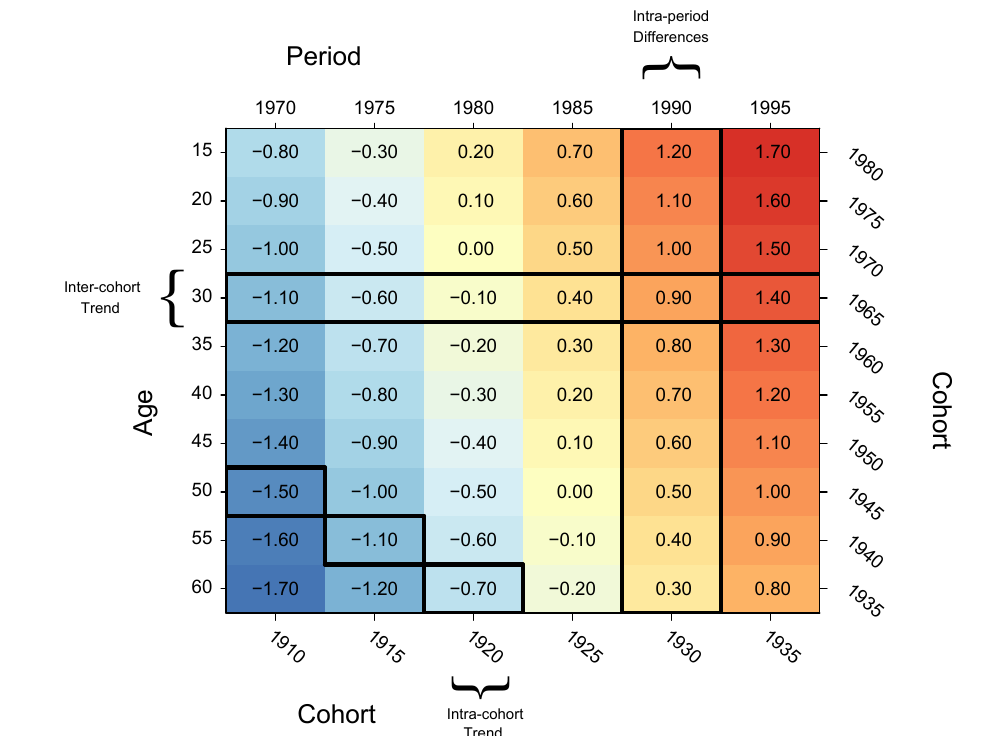
Figure 1: Two-dimensional age–period–cohort Lexis heat map of diachronic trends and synchronic differences. Notes: Each cell gives the mean outcome based on simulated data using values of θ 1 = 0.08 and θ 2 = 0.10. Three sections are highlighted: the diachronic intra-cohort trend for the birth cohort born in 1920 (diagonal section), the diachronic inter-cohort trend for those aged 30 years (horizontal section), and intra-period differences for those in the 1990 period (vertical